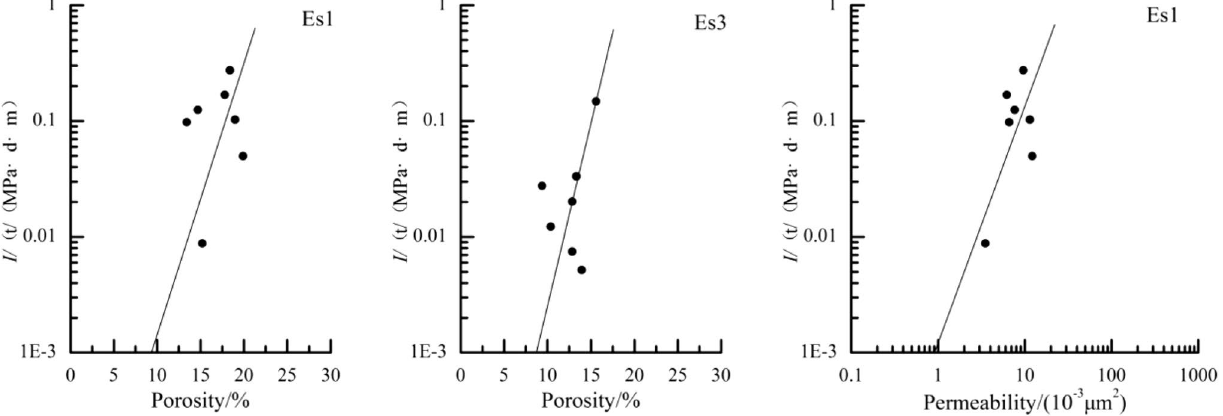
Fig. 3 Lower limit of physical properties determined by the oil production index test method